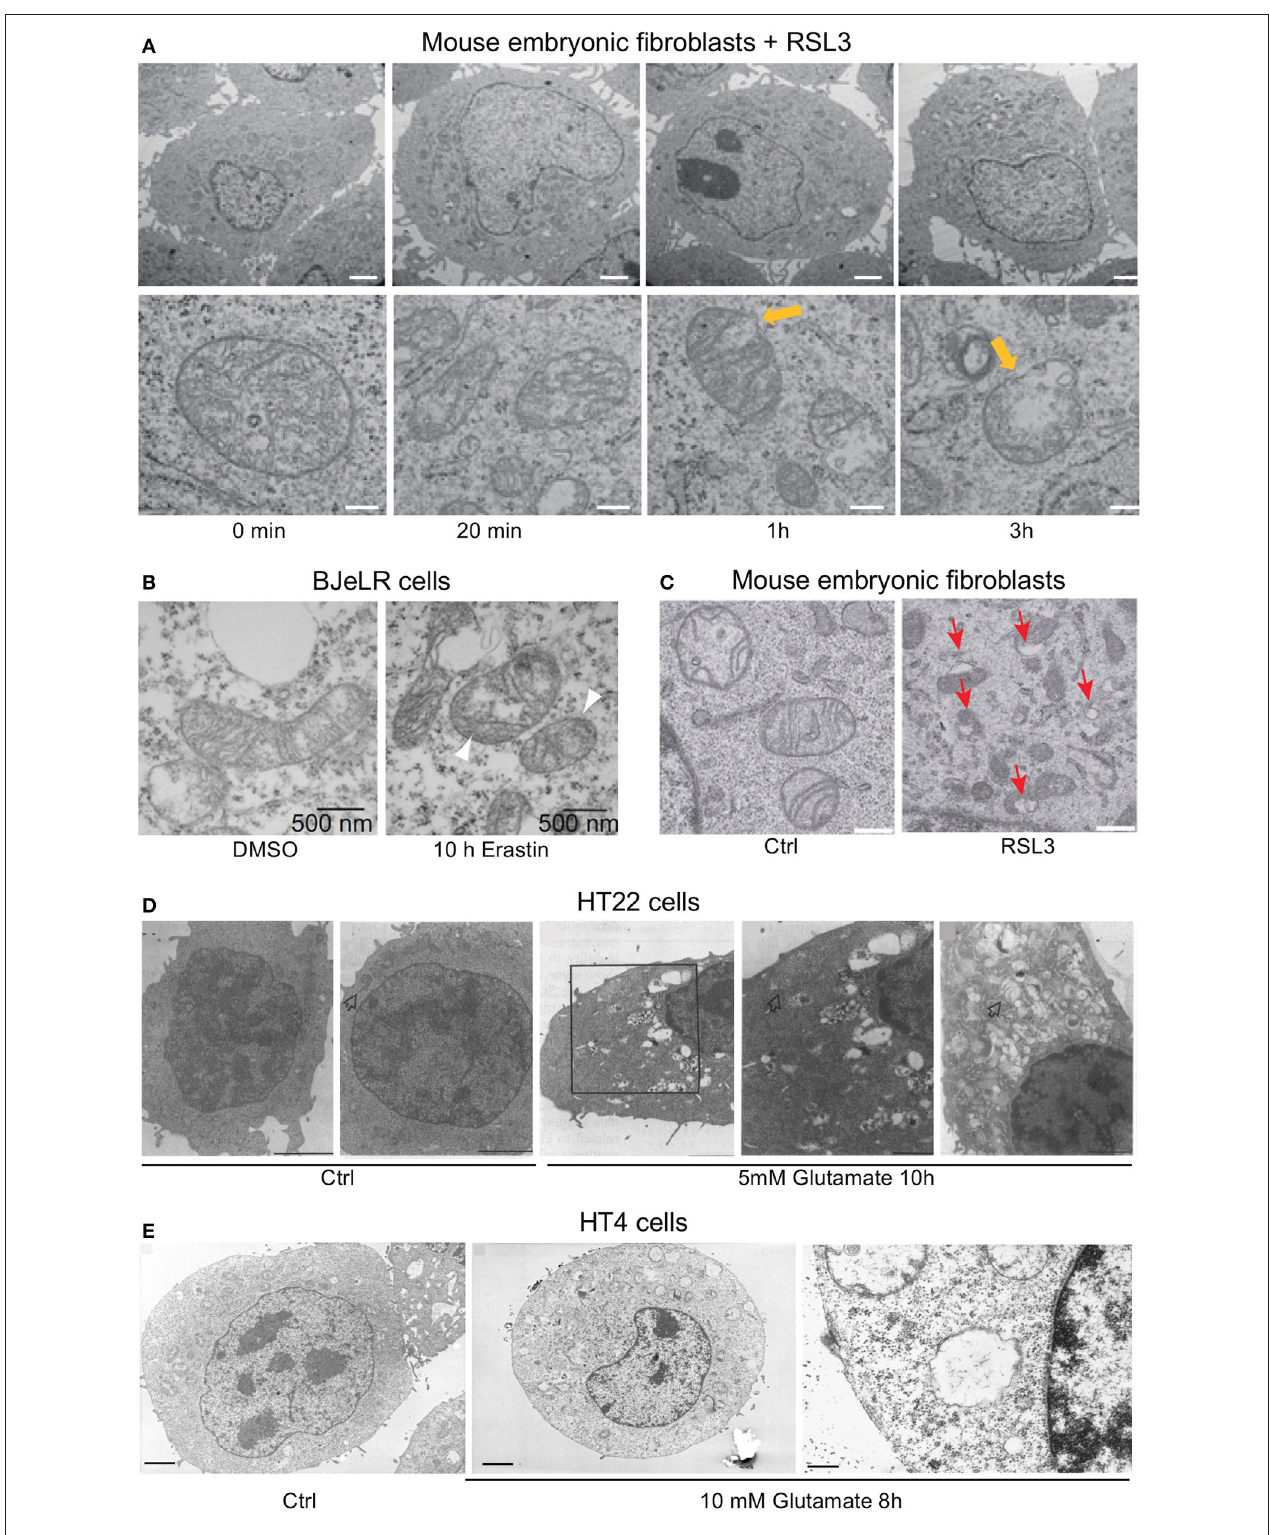
FIGURE 1 | Ultrastructural changes in cells undergoing ferroptosis and oxytosis comprise prominent but diverse mitochondrial abnormalities while nuclear integrity is preserved. Electron micrographs of (A) mouse embryonic fibroblasts (MEF) showing a time-dependent outer mitochondrial membrane rupture (yellow arrows)